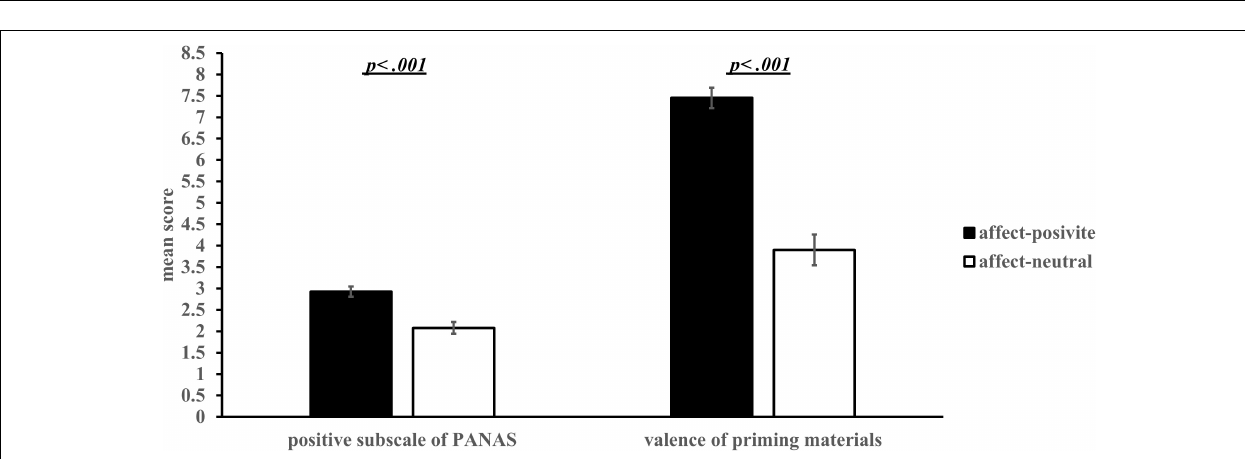
FIGURE 1 | Experimental procedure with example tasks: (A) IC task, (B) Time perception task.[In both studies, the experimental materials were all presented in Chinese.] For A, the option pair is displayed until participants make a choice.